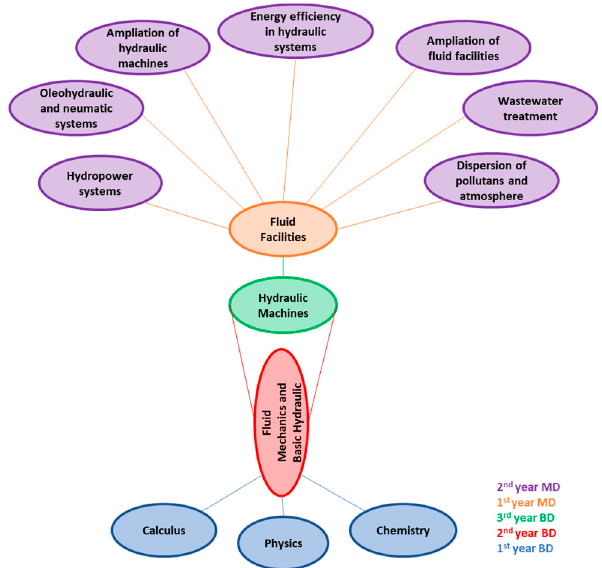
Figure 1. Structure hydraulic engineering subjects at Universitat Politècnica de Valencia (UPV; BD.— Bachelor’s degree and MD.—Master’s